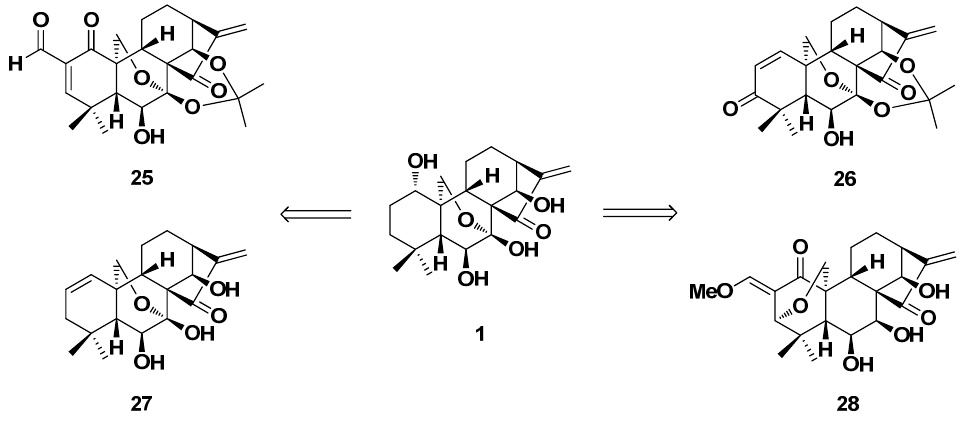
Figure 12. The dienone derivatives ( 25 – 28 ) of oridonin with the α , β -unsaturated ketone system in the A-ring.